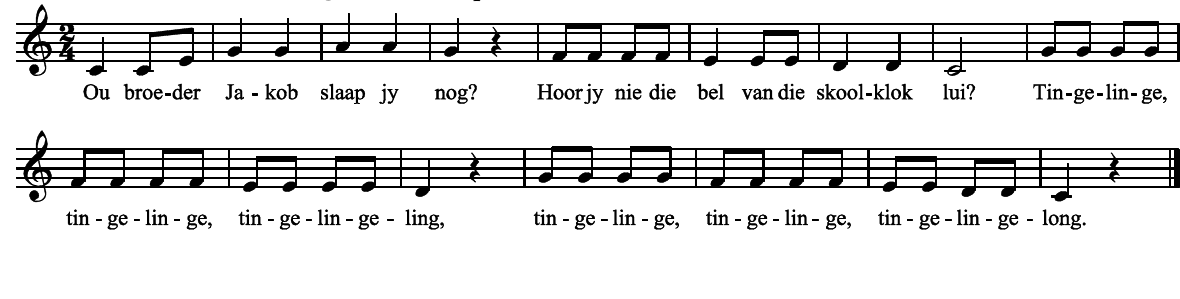
Fig. 3. Frère Jacques: alternative Afrikaans